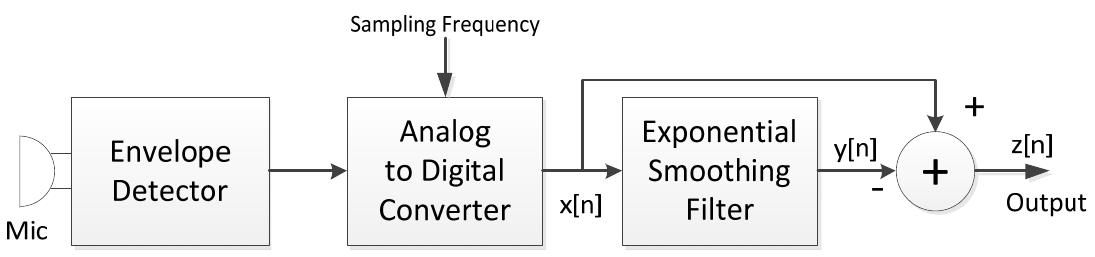
Figure 3. Individual node